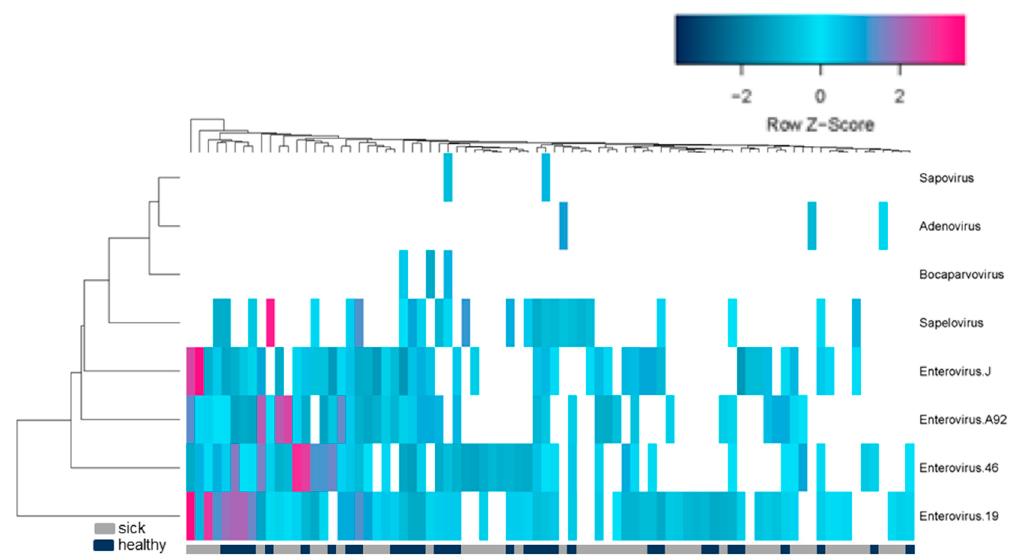
Figure 3. Relative abundance of viruses from rectal swabs. Unsupervised hierarchical clustering analysis of fecal swab viromes suggests that there is no distinction between ICD cases and healthy controls.